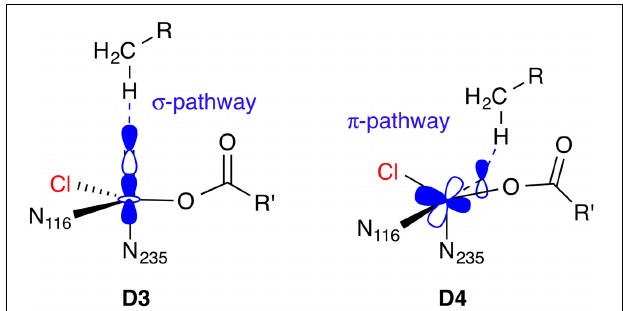
FIGURE 8 | Hydrogen abstraction pathways for 5 [Fe IV = O] isomers D3 and D4. In the σ -pathway, an electron from the C–H bond is accepted into the σ ∗ (Fe = O) orbital, hence an attack angle of 180 ◦ is ideal. In the π -pathway, the acceptor orbital is a π ∗ (Fe = O), so the ideal attack angle is around 120 ◦